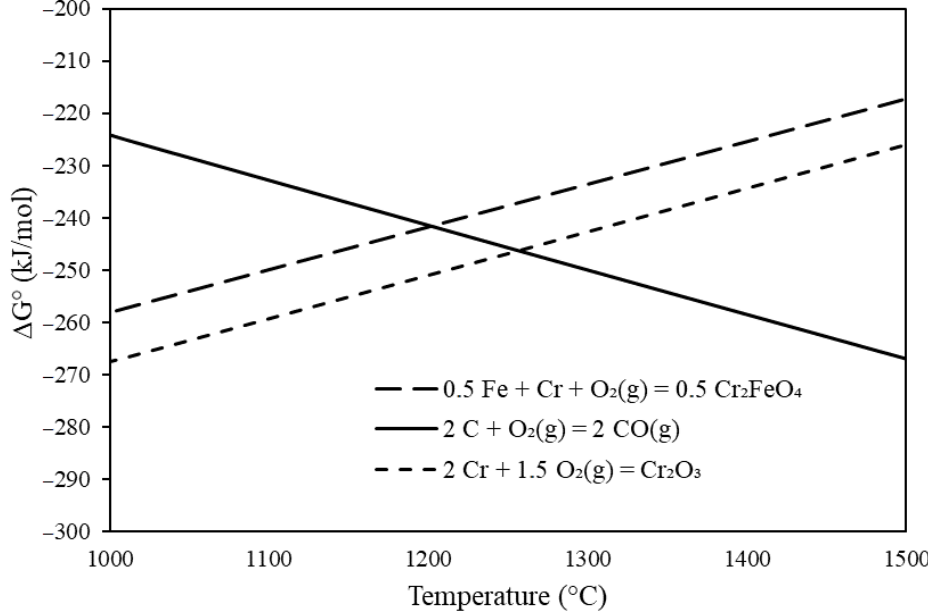
Figure 8. Ellingham diagram ( ∆ G ◦ as a function of temperature) indicating standard ∆ G ◦ of the reduction of Cr 2 O 3 and Cr 2 FeO 4 with solid C (constructed with HSC thermochemical software) [75].